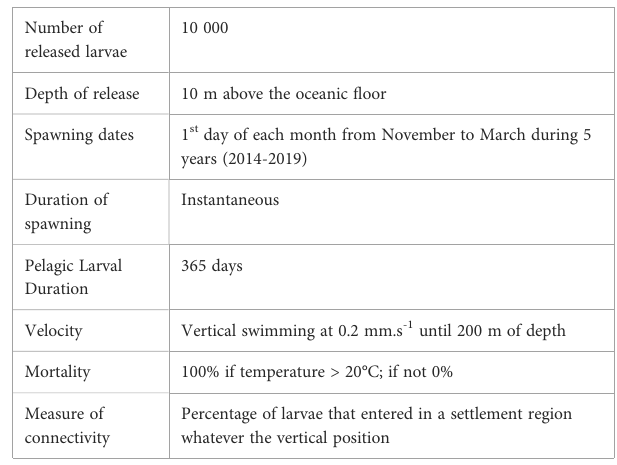
TABLE 3 Summary of larval characteristics used in the larval dispersal modelling using